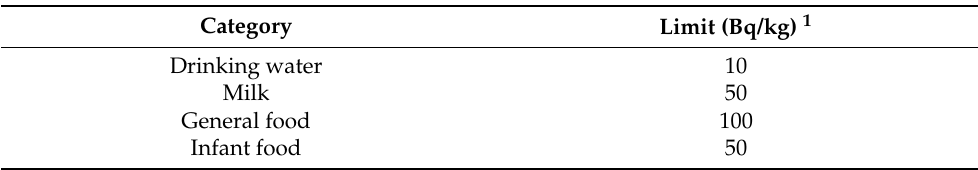
Table 1. Current standard limits for radioactive cesium (sum of Cs-134 and Cs-137) in foodstuffs in Japan (applied on 1 April